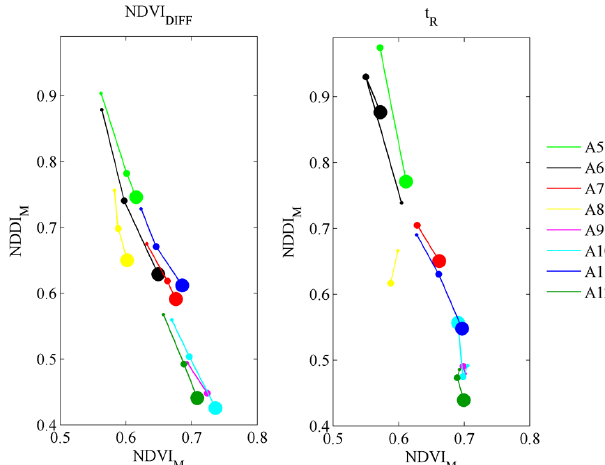
Fig. 10. Centroids of { NDVI M , NDDI M } respecting to each class of fire damage (NDVI DIFF , left panel) and recovery time ( t R -right panel) for selected burnt scars from 2005. Size of markers indi- cates low, intermediate and high classes of fire damage and recovery times. Coordinates of the centroids are identified by filled circles in the dispersion